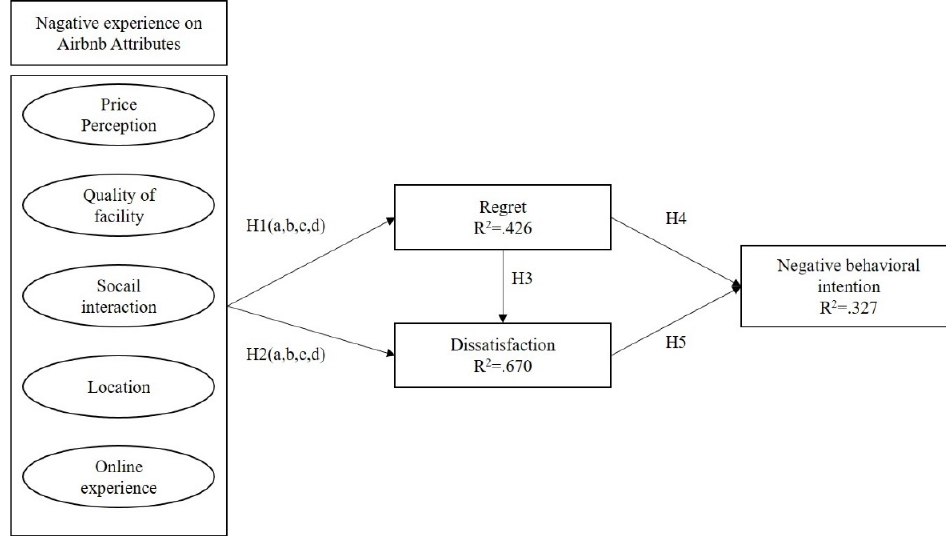
Figure 1. Research